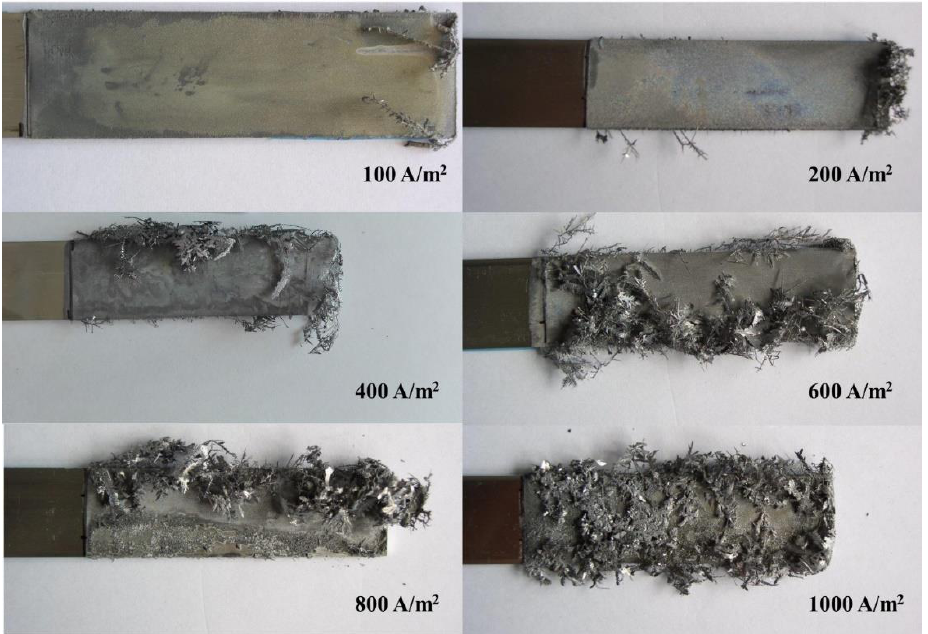
Figure 3. Photos of lead electrodeposited from the triethylenetetramine solution at different current densities .